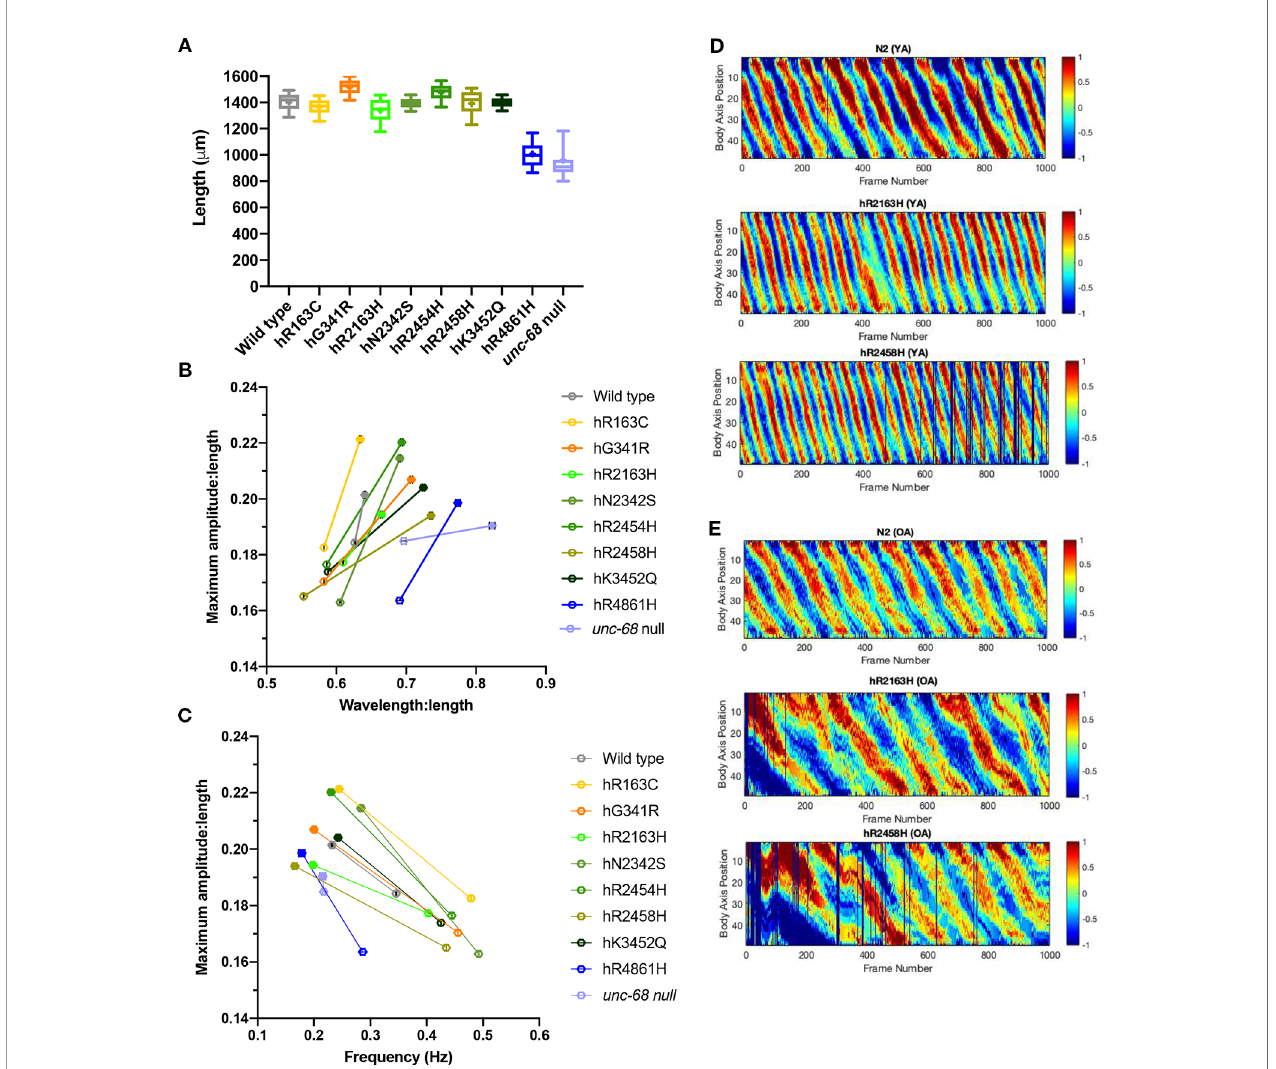
FIGURE 4 | Effect of ryanodine receptor (RyR) variants on crawling changes with ageing. Crawling amplitudes, wavelengths and frequencies, and worm lengths, were extracted from 1 min long, 25 frames per second, video recordings of 20 – 30 individual 10-day old adults. Worm length (A) , maximum amplitude versus wavelength (B) and maximum amplitude versus frequency (C) for RyR variant strains, labelled by the human variant they correspond to, along with the N2 wild type and the CB540 unc-68(e540 ) null mutant, were compared. Maximum amplitude and wavelength were normalized for worm length. Boxes indicate the median and interquartile range, with whiskers to the 10 – 90 percentile, outliers as dots, and + to indicate the mean (A) . Mean and SEM are indicated, although SEM is very small for frequency and for normalized maximum amplitude and wavelength (B, C) . The change in maximum amplitude and primary wavelength from young adult (hollow symbols) to old adult (solid symbols), is indicated by a straight line (B, C) . Representative kymograms are presented for the N2 wild type and for hR2163H and hR2458H RyR variant strains for (D) young adults (YA) and (E) old adults (OA). Colour indicates degree of dorsal/ventral curvature (red/blue high curvature, green no curvature) at different positions along the body axis (0 anterior to 50 posterior) for each frame of the video recording. Individual frames where parameters could not be extracted are